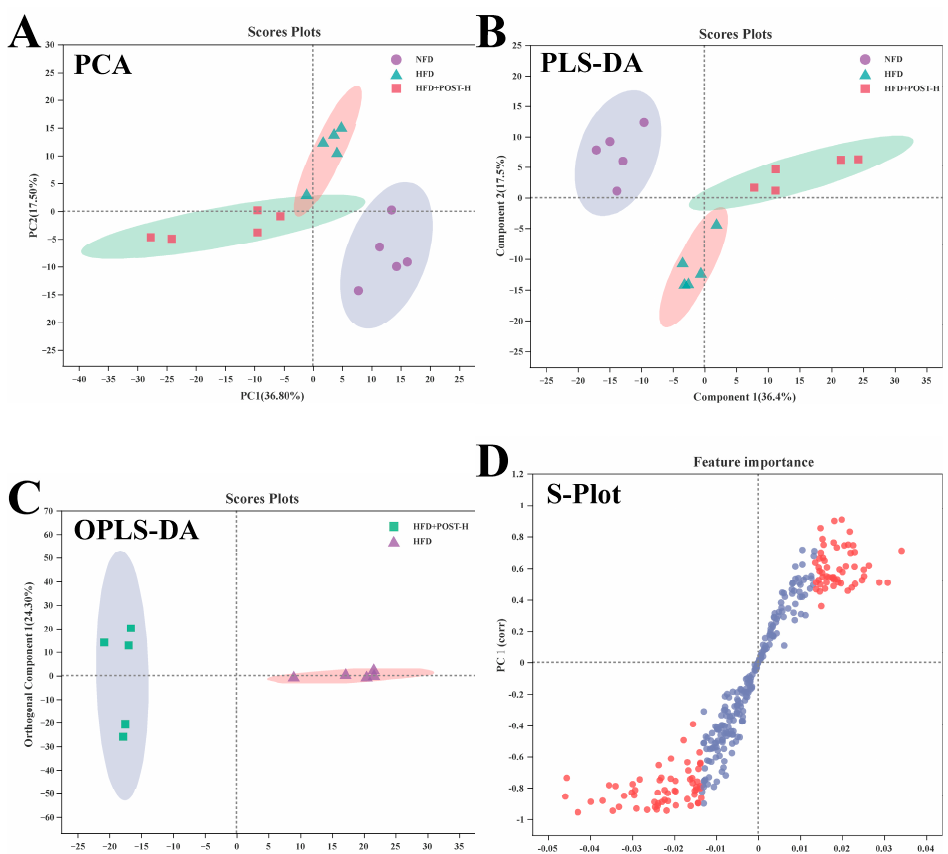
Figure 7. POST regulates hepatic metabolism (ESI+). ( A ) PCA score of the NFD, HFD and HFD + POST-H. ( B ) PLS-DA score of the NFD, HFD and HFD + POST-H. ( C ) OPLS-DA score of the HFD and HFD + POST-H. ( D ) S-loading plot based on OPLS-DA analysis of the HFD and HFD + POST-H. The red points indicate that these metabolites have a VIP value of 1 or greater, and the blue points indicate that these metabolites have a VIP value of less than 1. ( E ) Heat map of relative abundance of differential metabolites in liver between HFD and HFD + POST-H. ( F ) The effects of POST-H on liver metabolic pathways were analyzed based on KEGG.